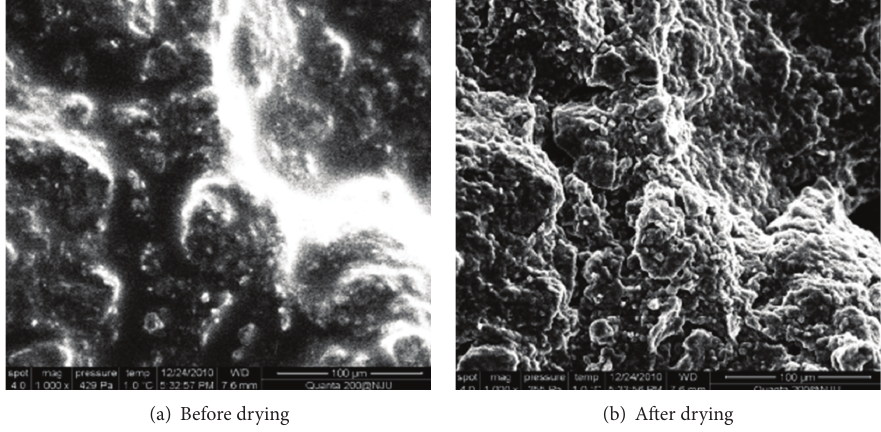
Figure 1: ESEM images of Romainville expansive soil during